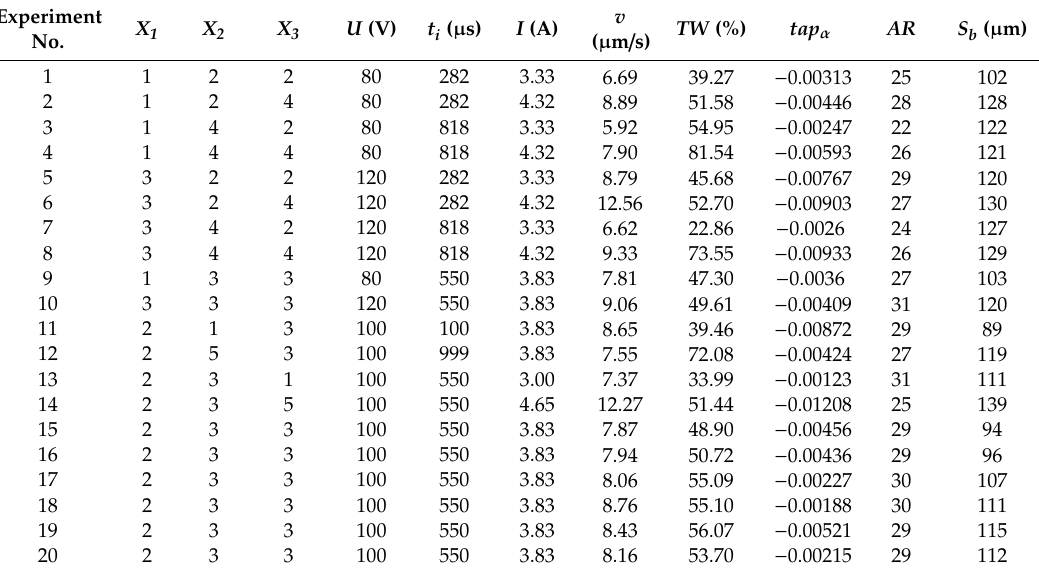
Table 5. Research plan and the results of the experiments.